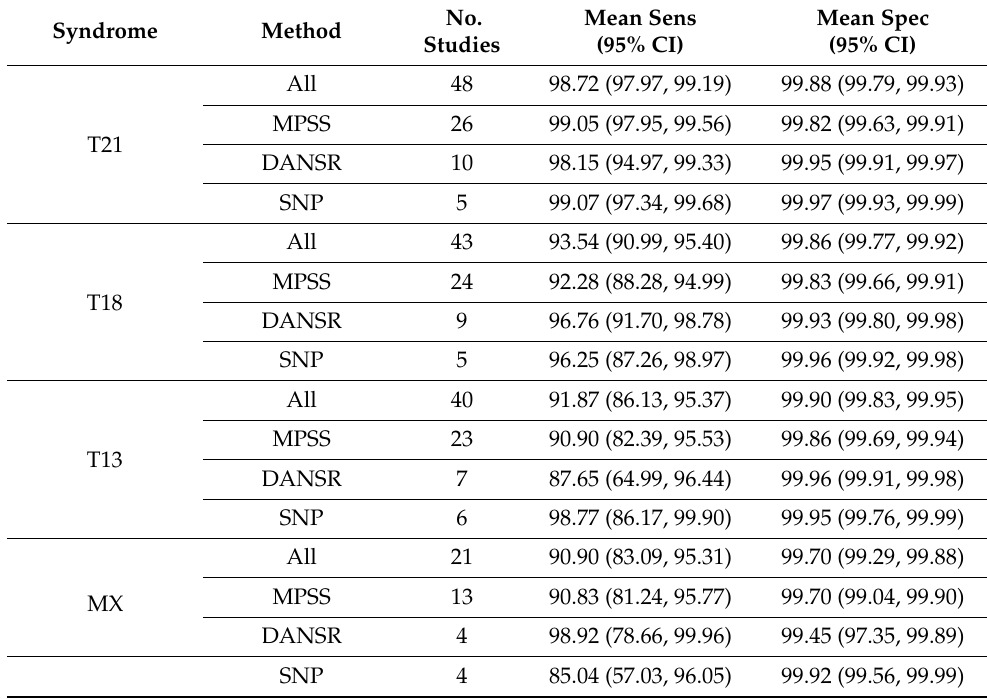
Table 2. Validation studies: summary estimates for Sensitivity (Sens) and Specificity (Spec) from bivariate model, by syndrome and